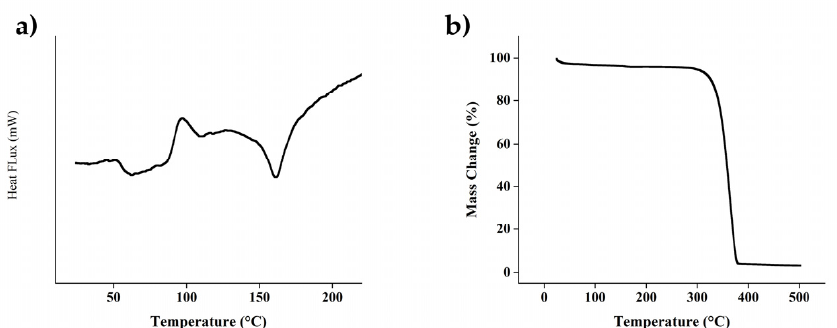
Figure 4. Result of thermal characterization using ( a ) Differential Scanning Calorimetry and Thermal Gravimetric Analysis for PLA. ( b ) Thermaogravimetry Analysis for PLA.